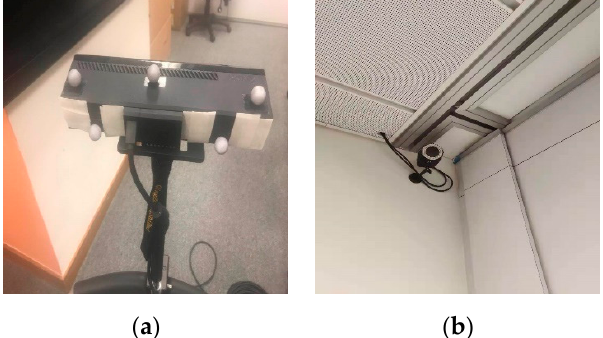
Figure 6. Experiment device. ( a ) Kinect v2; ( b ) Qualisys, the motion capture system.